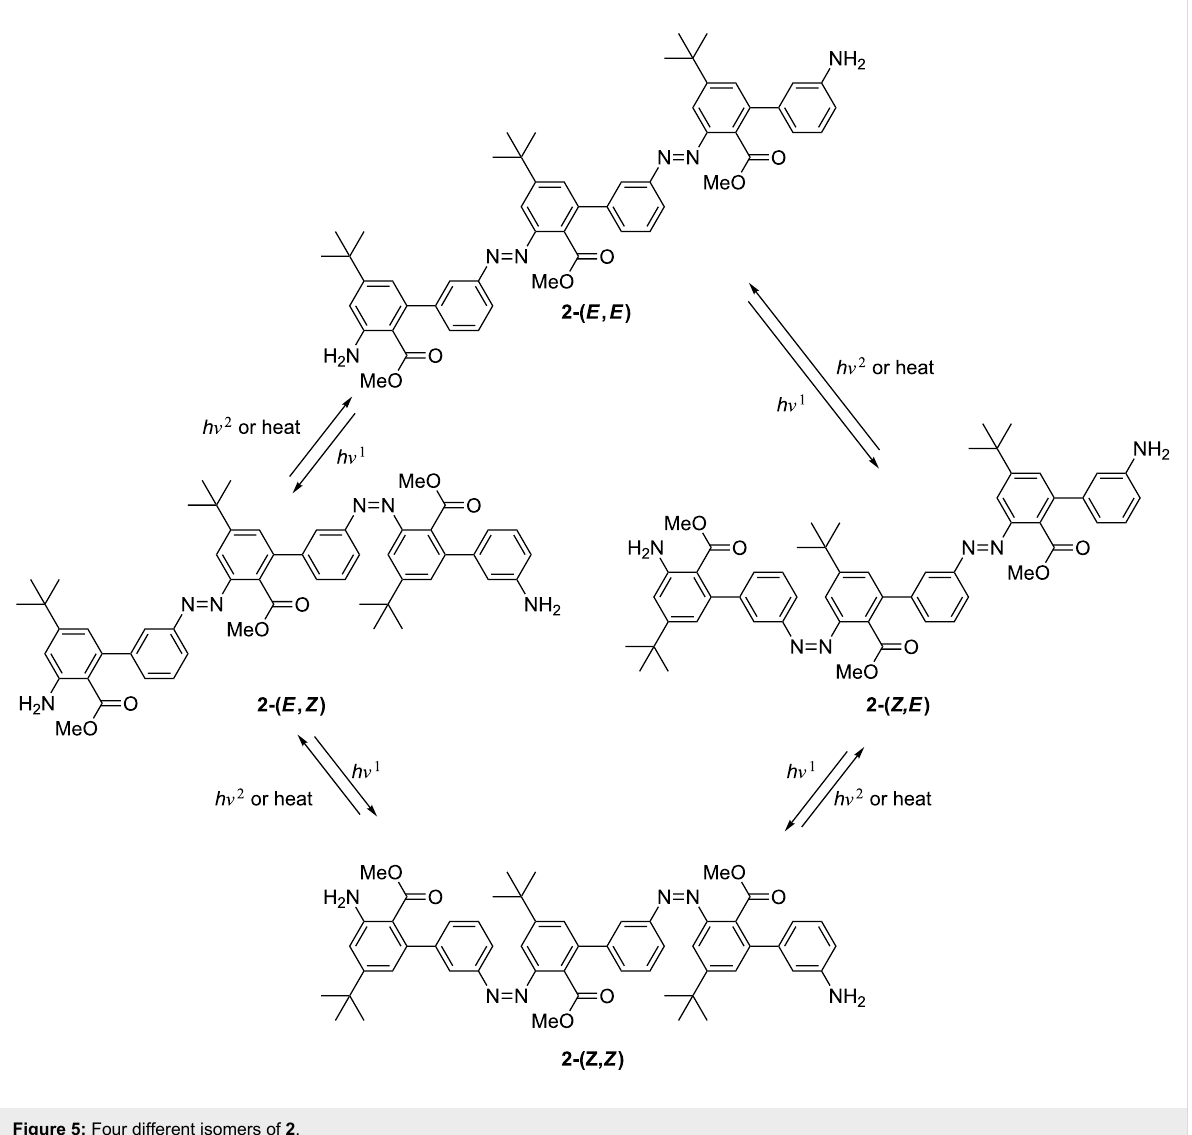
Figure 5: Four different isomers of 2